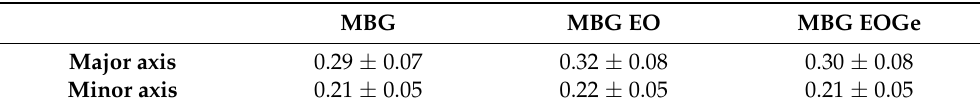
Figure 4. ( a ) Major and minor diameters of the MBG EOGe particles measured by DIP, ( b ) coalesced MBG particles. Table 1. Value for media and SD for the major and minor axis measured for the synthetized particles, in µ m. MBG MBG EO Major